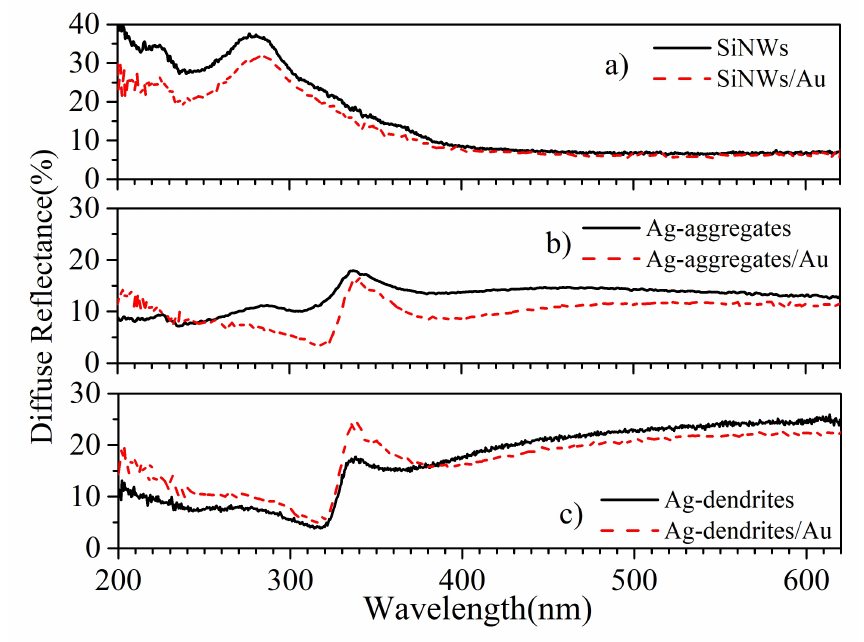
Figure 4. Diffuse reflectance spectra for the different substrates considered in this work: ( a ) Bare SiNWs (full line) and SiNWs enriched with 70 nm diameter AuNPs (dashed line, SiNWs/Au); ( b ) Ag-aggregates (full line) and Ag-aggregates enriched with 70 nm diameter AuNPs (dashed line, Aggregates/Au). Structures are shown in Figure 3; ( c ) Ag-dendrites (full-line) and Ag-dendrites with 70 nm diameter AuNPs (dashed line, Ag-Dendrites/Au). Structures are shown in Figure